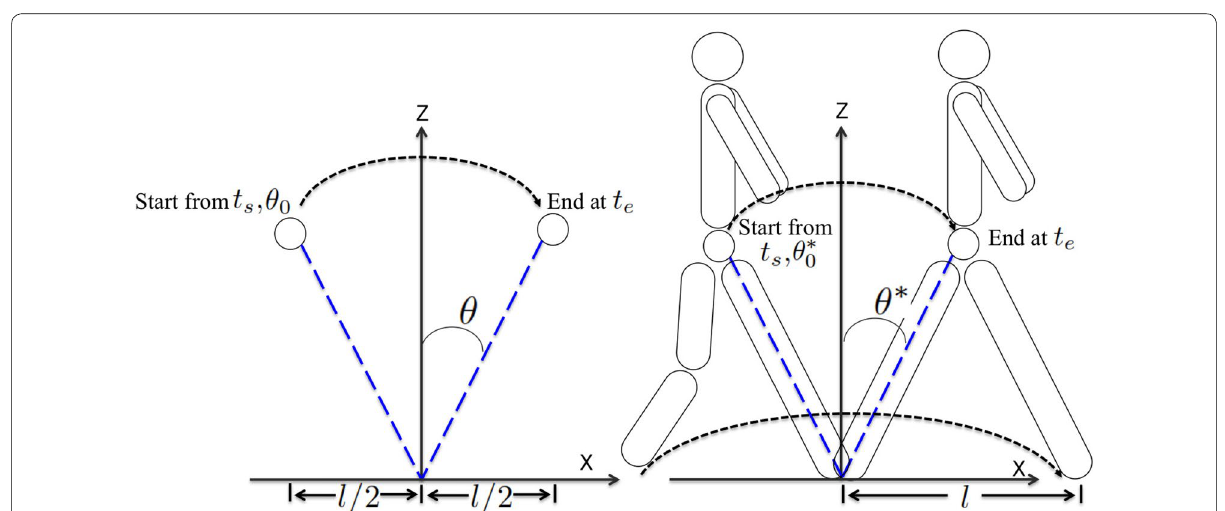
Fig. 4 Relationship between pendulum and human walking in gait